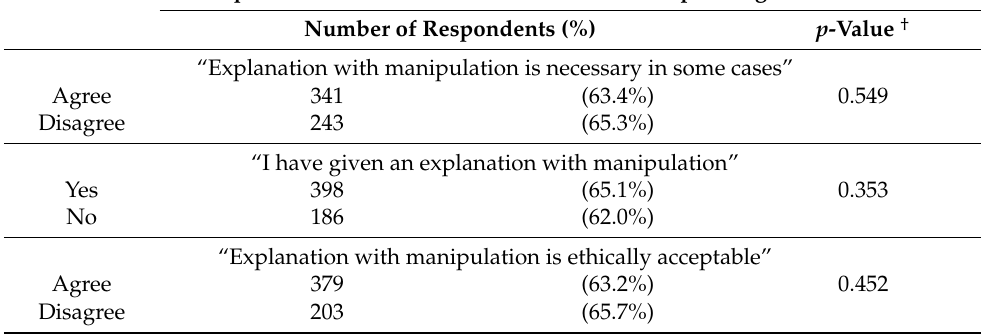
The presence of a nurse by awareness and action with reference to explanation with